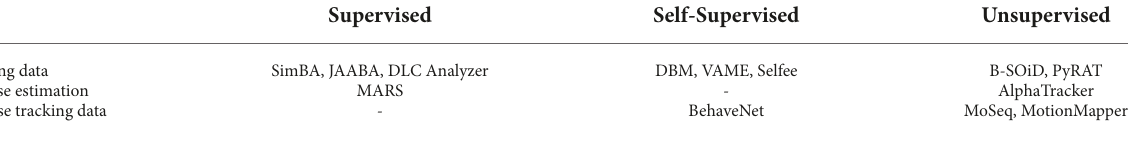
TABLE 1 Behavior classification